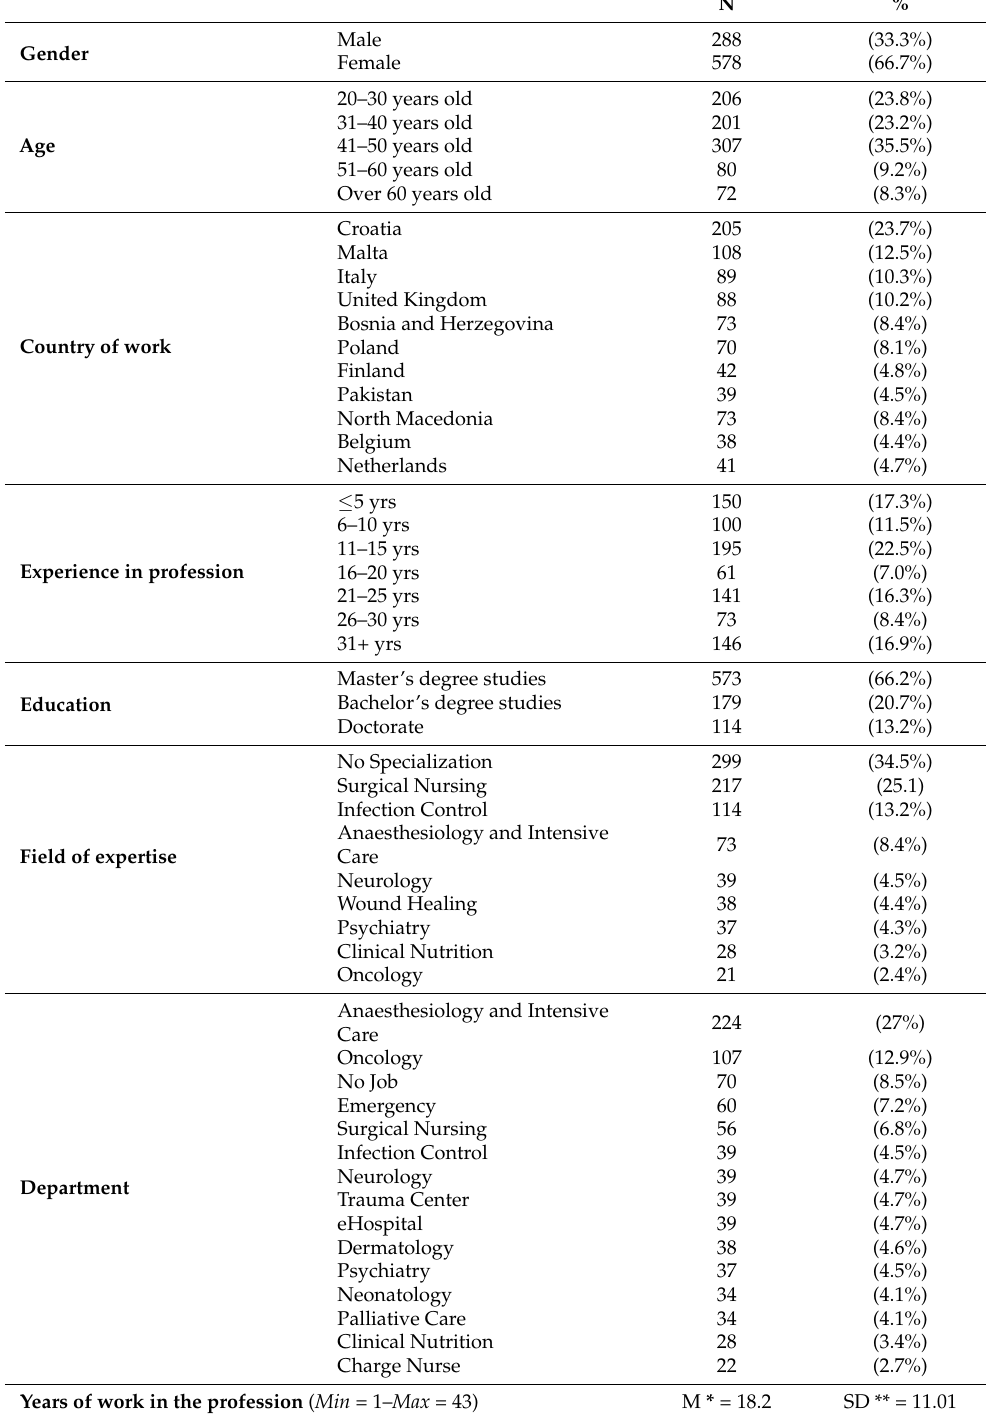
Table 1. Sociodemographic factors (N =